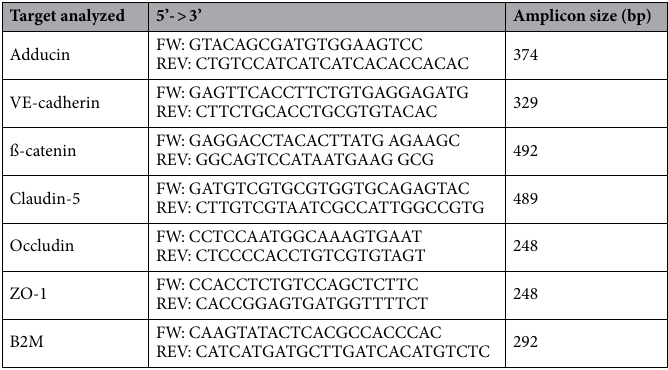
Table 1. Primer sequences and amplicon size corresponding to each indicated